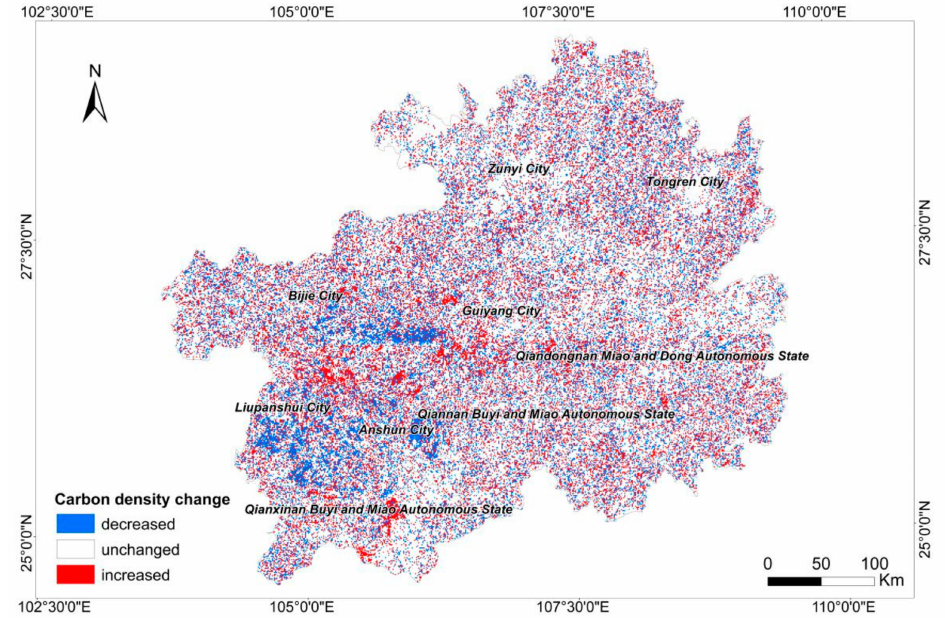
Figure 5. Carbon storage change map of the Guizhou terrestrial ecosystem from 2010 to 2020.